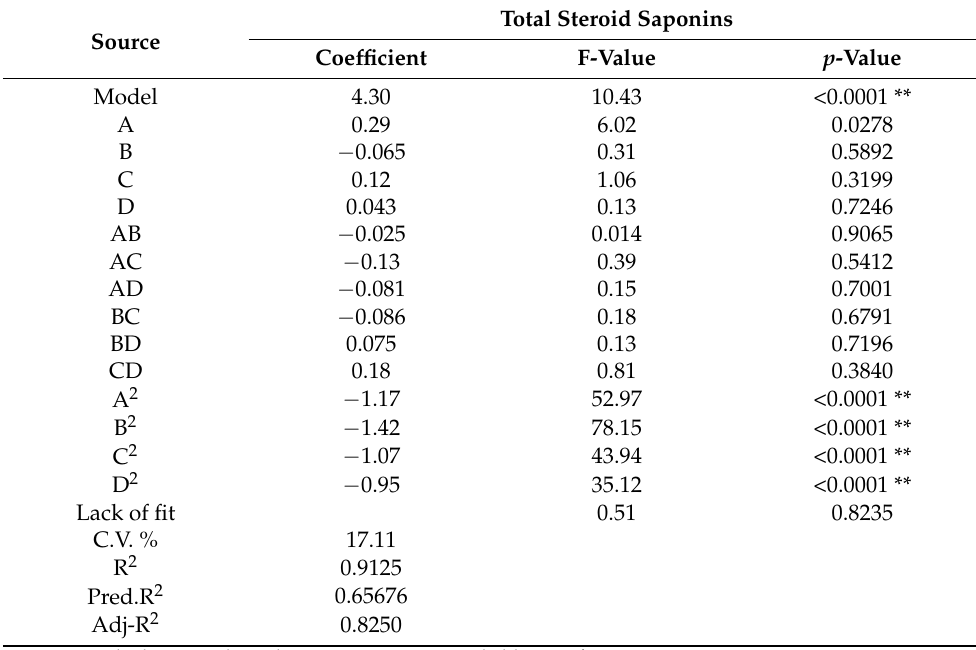
Table 2. ANOVA of response surface model and predicted results for response of four